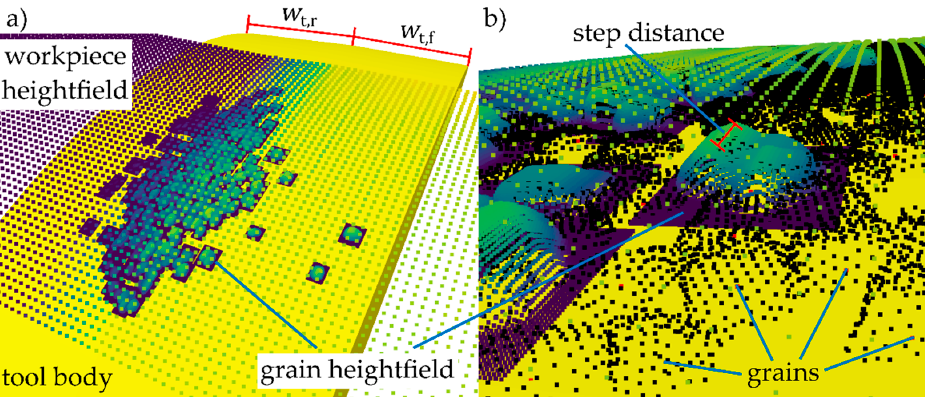
Figure 11. Visualisation of the grain heightfields created in every step. While the grain heightfields are rendered in full detail, only every 25th point of the workpiece heightfield is shown. ( a ) The concentration of engaged grains, typical for ITG, is exhibited in the roughing zone. ( b ) The detailed view shows that for some grains, which are not in proximity of the workpiece, no heightfield is created.